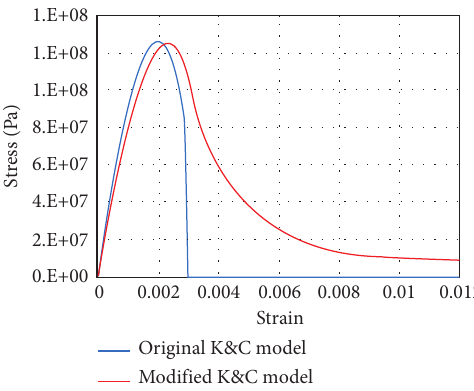
Figure 22: The stress and strain of the uniaxial unconfined compression strength of the concrete.